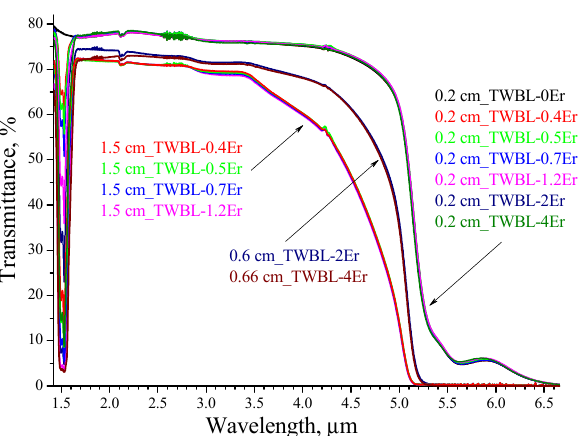
Figure 4. IR transmission spectra of TeO 2 -WO 3 -Bi 2 O 3 -(4-x)La 2 O 3 -xEr 2 O 3 glass samples with differ- ent thicknesses.